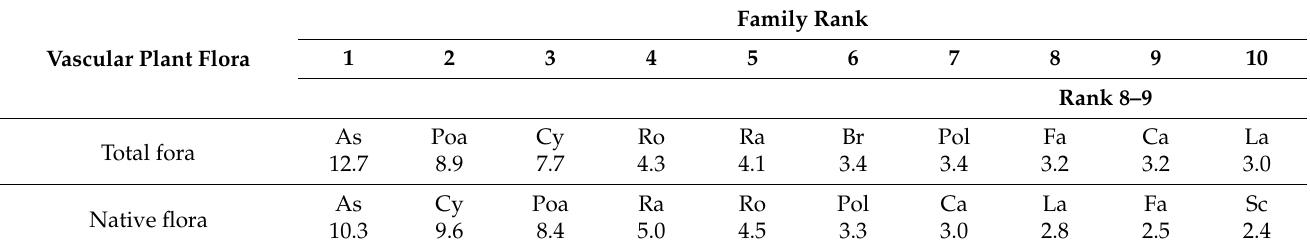
Table 1. Structure of the head family spectrum according to percentage of plant species in a